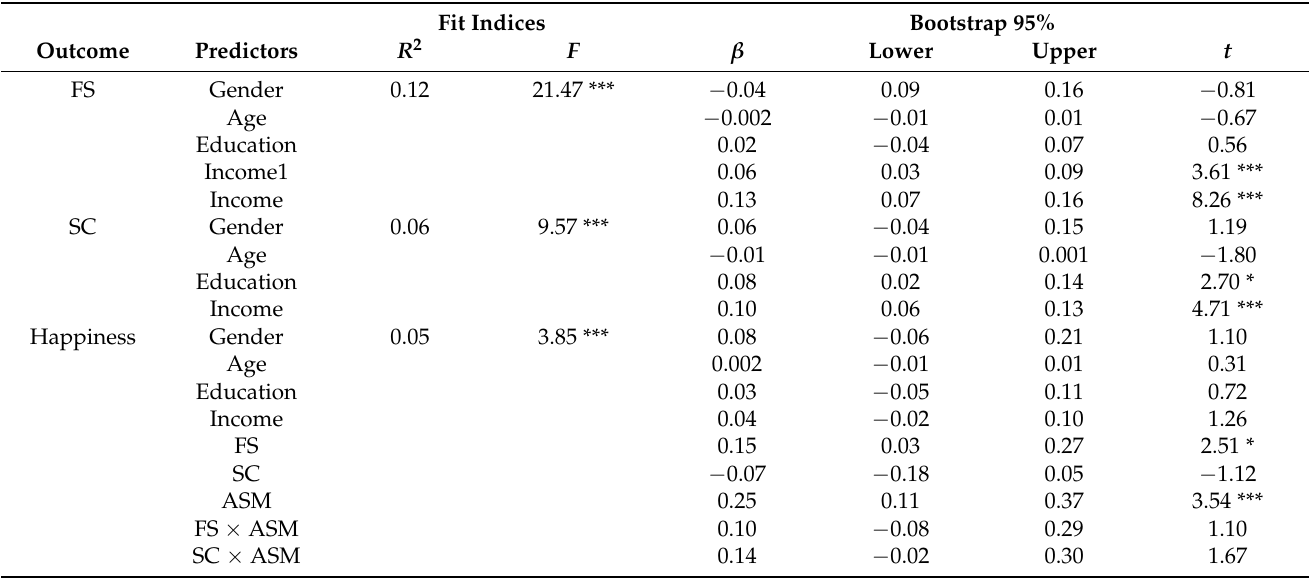
Table 7. Testing the moderated mediation effects for Happiness in study